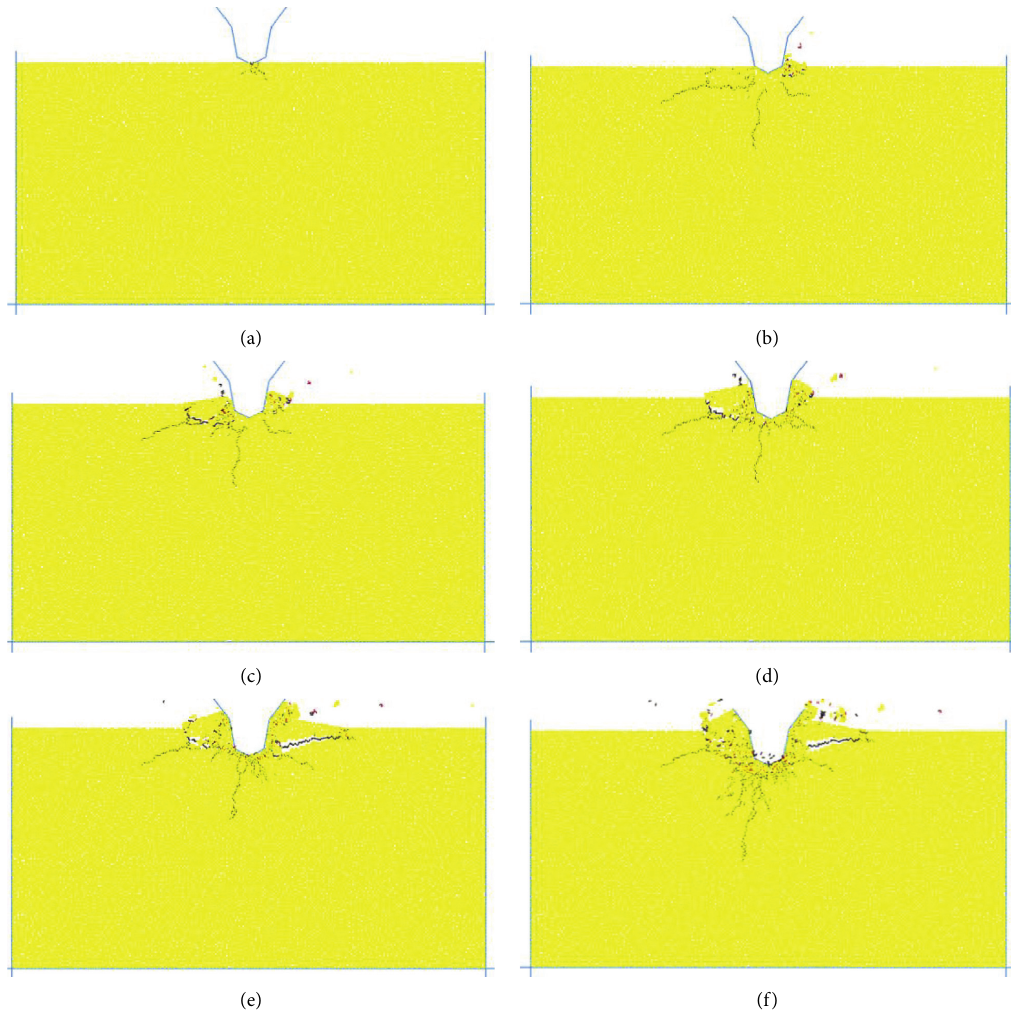
Figure 2: Failure characteristics of rock mass during rock breaking by disc cutter. (a) Intrusion 1.0mm. (b) Intrusion 3.0 mm. (c) Intrusion